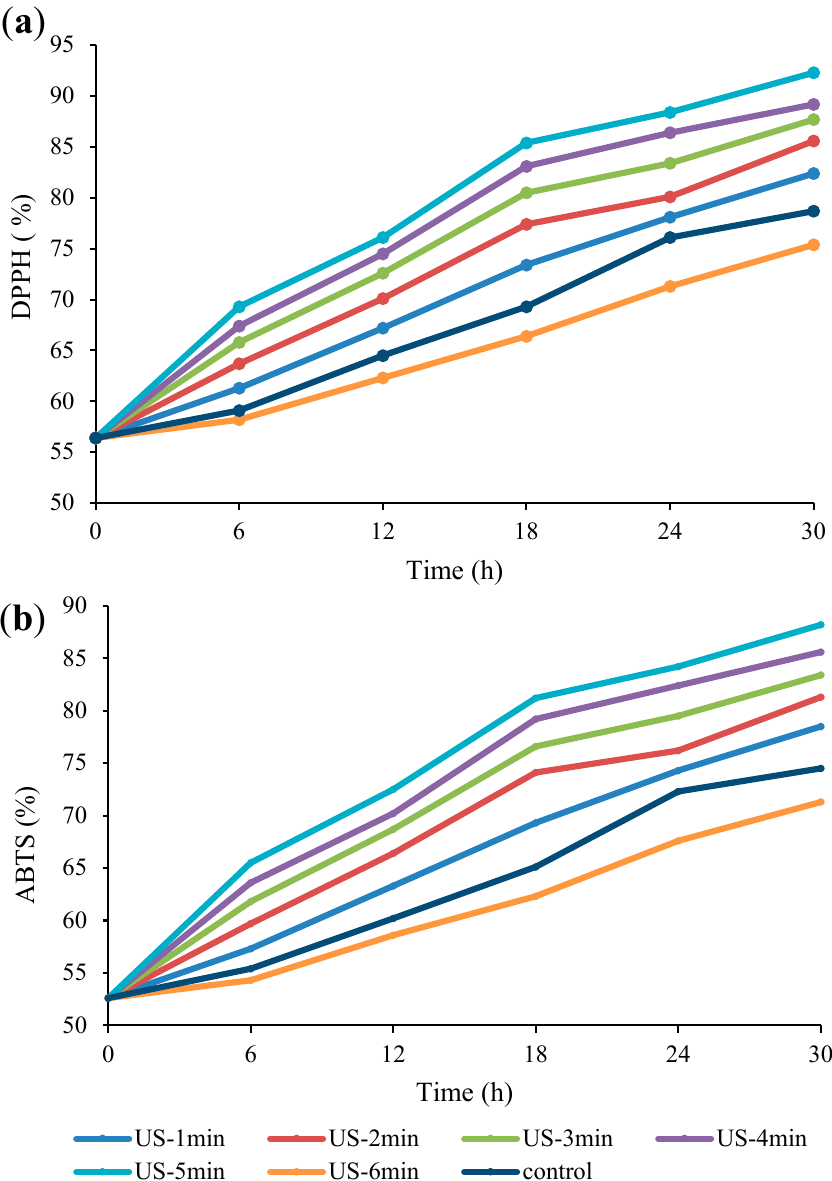
Figure 5. Changes in antioxidant activity (DPPH ( a ), ABTS ( b )) of US-treated and non-US treated Bakraei juice during fermentation. Error bars reveal the standard deviation of each measurement in Bakraei juice during 30 h of fermentation. US-1 min: ultrasound treatment for 1 min, Control: non-ultrasound treated juice.